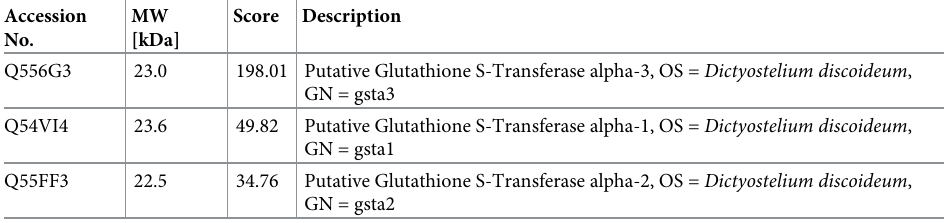
Table 2. Mass spectrophotometric analysis of GSH-affinity proteins from cell lysates. Accession No.